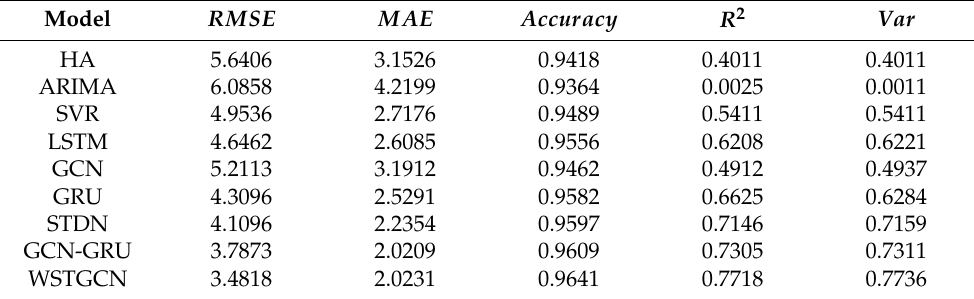
Table 5. Comparison of 45-min speed